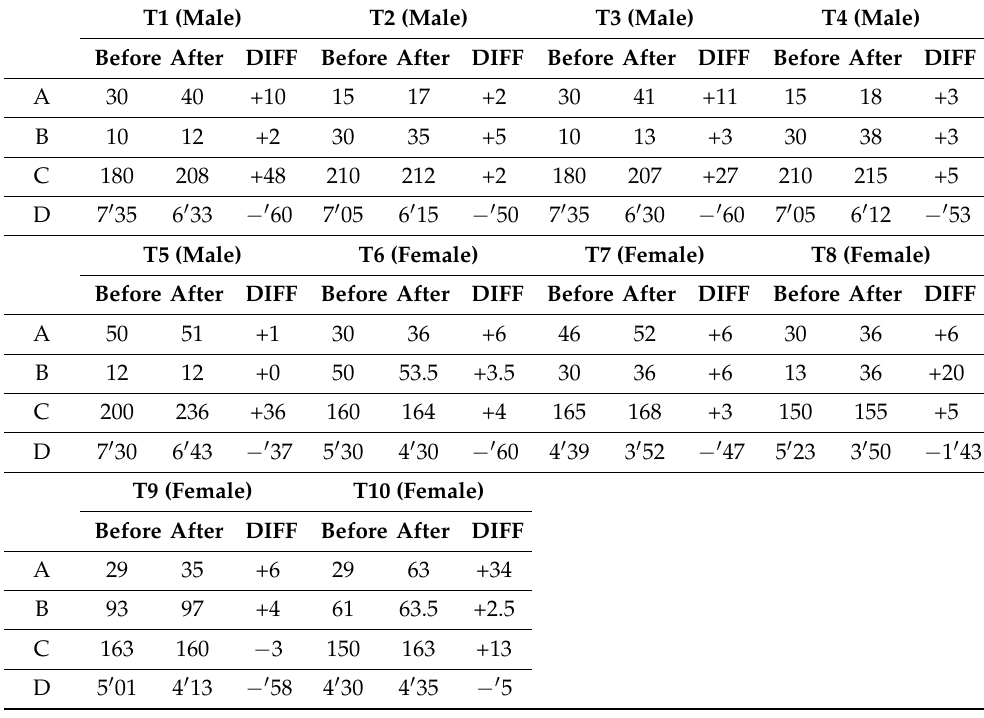
Table 2. Statistical difference analysis of physical fitness of the experimental group before and after the